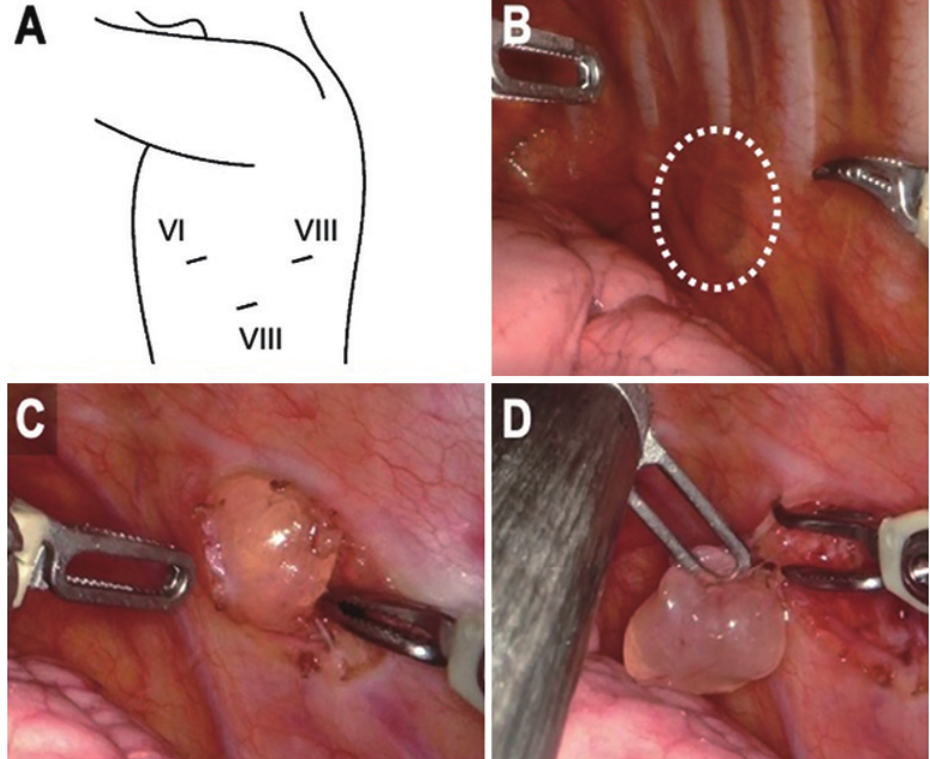
Figure 2. Intraoperative photographs. Configuration of port incisions in robot-assisted thoracoscopic surgery (RATS) and intraoperative photographs. ( A ) In the illustration, the lines marked with VI and VIII indicate the 6th and 8th intercostal spaces (ICSs), respectively. An 8-mm camera port is placed at the 8th ICS in the mid-axillary line as the second arm. Two 8-mm assisted ports are inserted at the 6th ICS anteriorly in the anterior-axillary line as the first arm and the 8th ICS on the posterior axillary line as the third arm. ( B ) When the inside of the thoracic cavity is observed with a rigid 30° oblique view- ing endoscope, a tumor visible through the parietal pleura is found at the level of the left 5th thoracic vertebra. The tumor is indicated by the white dotted circle. ( C ) The lower end of the tumor is gripped and pulled with robotic instruments, and the tumor moves from the parietal pleura. ( D ) Since the cystic mass is discontinuous with the intercostal nerves and vessels, a complete incision is easily made from the posterior mediastinum. All three photographs ( B - D ) are extracted from digital video